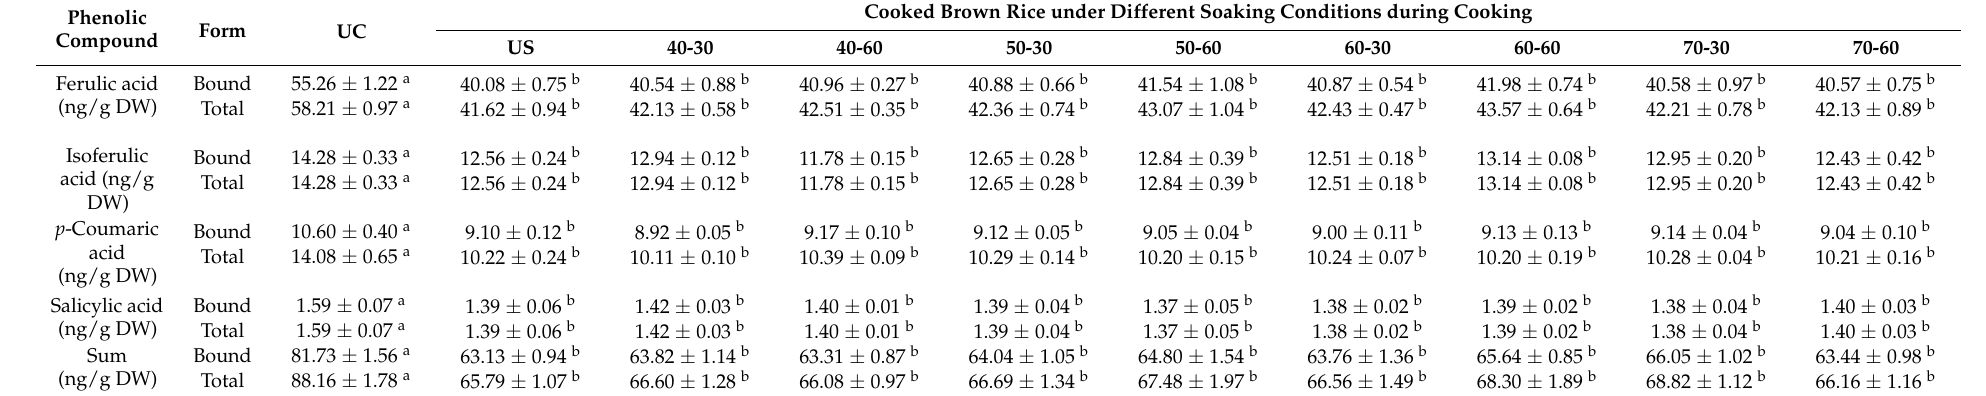
Table 2. Phenolics profile of uncooked and cooked brown rice under different soaking conditions during